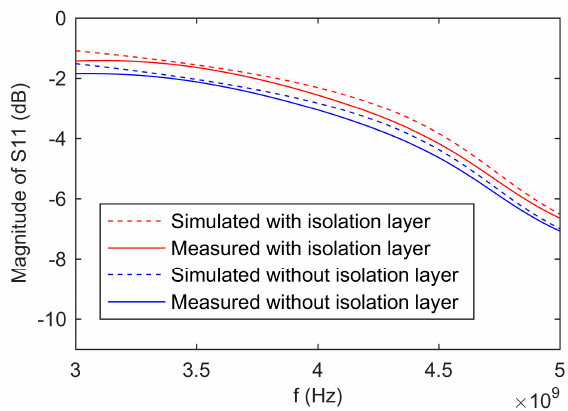
Figure 4. Simulated and measured results of S-parameter of the proposed sensor with isolation layer and without isolation layer.